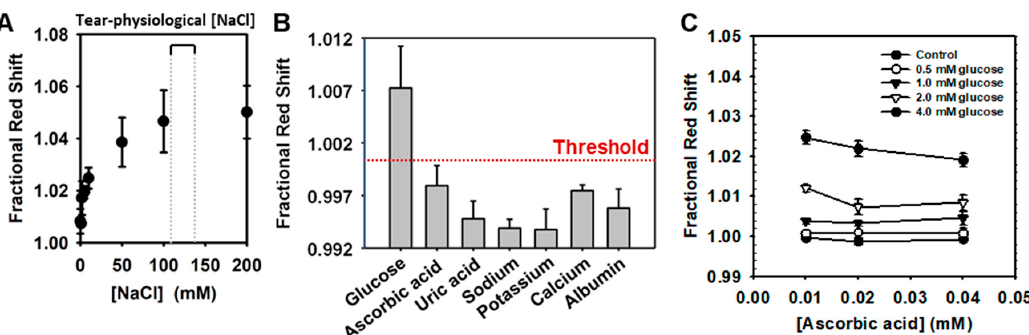
Figure 4. ( A ) Ion effect of chloride ion on gold formation (the marked area stands for the physiological tear chloride concentration; 106–138 mM); ( B ) false-positive test with candidate factor possibly bringing matrix effect; ( C ) synergistic effect assessment with ascorbic acid-spiked samples, whereas the control means of a sample spiked only with ascorbic acid.